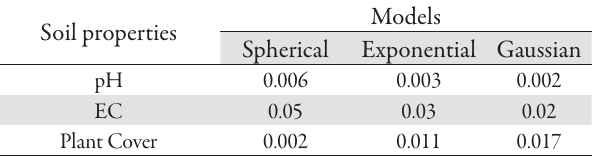
Tab. 7. Best-fitted variogram models of different soil properties and their parameters Soil Nugget Models properties (C ) O